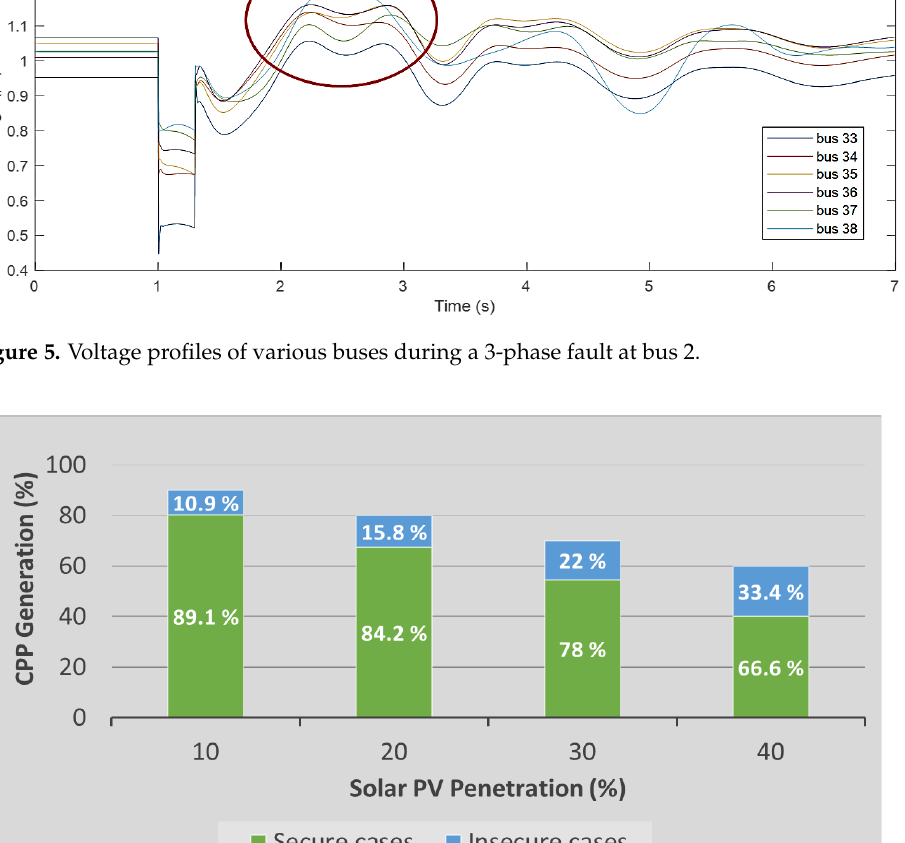
Figure 7. Summary of frequency stability analysis for different PV penetration levels.